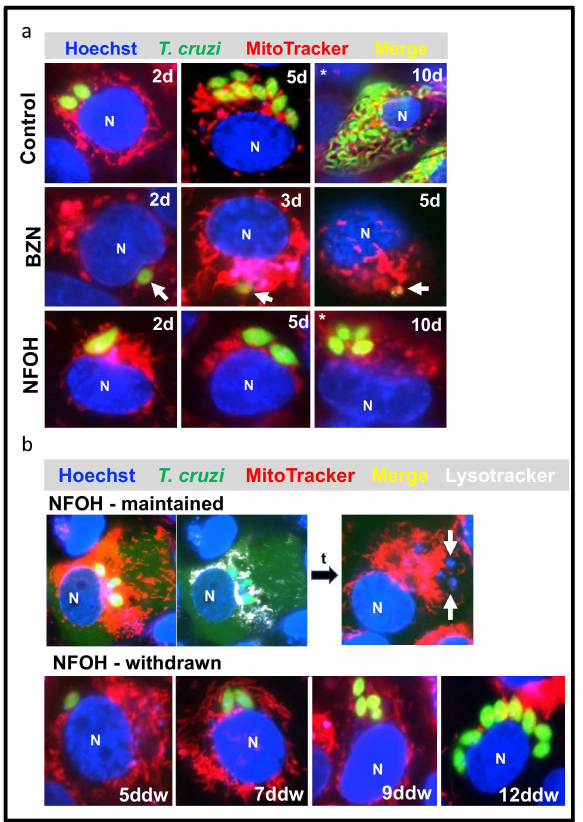
Figure 2. InfectionsofCOLO-680Ncellswith T.cruzi CL-Luc::Neonweremonitoredbyreal-timefluorescent microscopy. ( a ) Fate of intracellular amastigotes after NFOH and BZN treatment. Cell monolayers were infected with trypomastigotes (Materials and Methods), and drug treatment was initiated 48 h later. Treatment with 10 × IC 50 BZN caused parasite death by day 3 post-treatment, with a strong reduction in fluorescence, followed by parasite disintegration by day 5 (white arrow). 10 × IC 50 NFOH treatment slowed replication, but did not lead to parasites destruction. Untreated parasites underwent replication and released differentiated trypomastigotes by day 10 (control). ( b ) Wash out assays. Cultures were treated for 24 days with 20 × IC 50 of NFOH, leading to blocked parasite replication (upper panel). Intense lysosomal activity was observed around parasites following labelling with lysotracker (Materials and Methods). This was associated with leakage of parasite green fluorescent protein into the host cell cytoplasm. When the NFOH treatment was stopped after 12 days, intracellular parasites re-initiated replication and completed several rounds by 12 days after NFOH withdrawal (ddw) (lower panel). N = mammalian cell nuclei. The images are representative of 20 individual infected cells monitored in